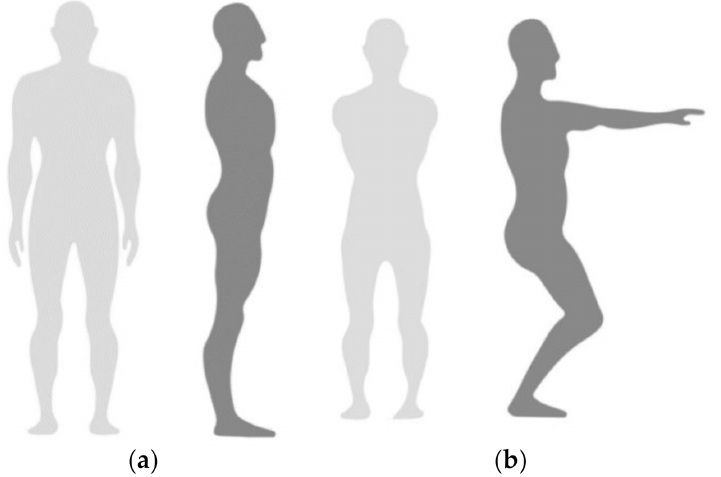
Figure 2. Subjects calibrate their posture. ( a ) A pose: Stand straight, arms facing down with palms facing your body. Position feet distance approximately the same distance of your hip width and maintain feet parallel to each other. ( b ) S pose: Crouch down with feet flat on the ground while maintaining feet and legs parallel to each other. Extend arms forward with palms facing down.